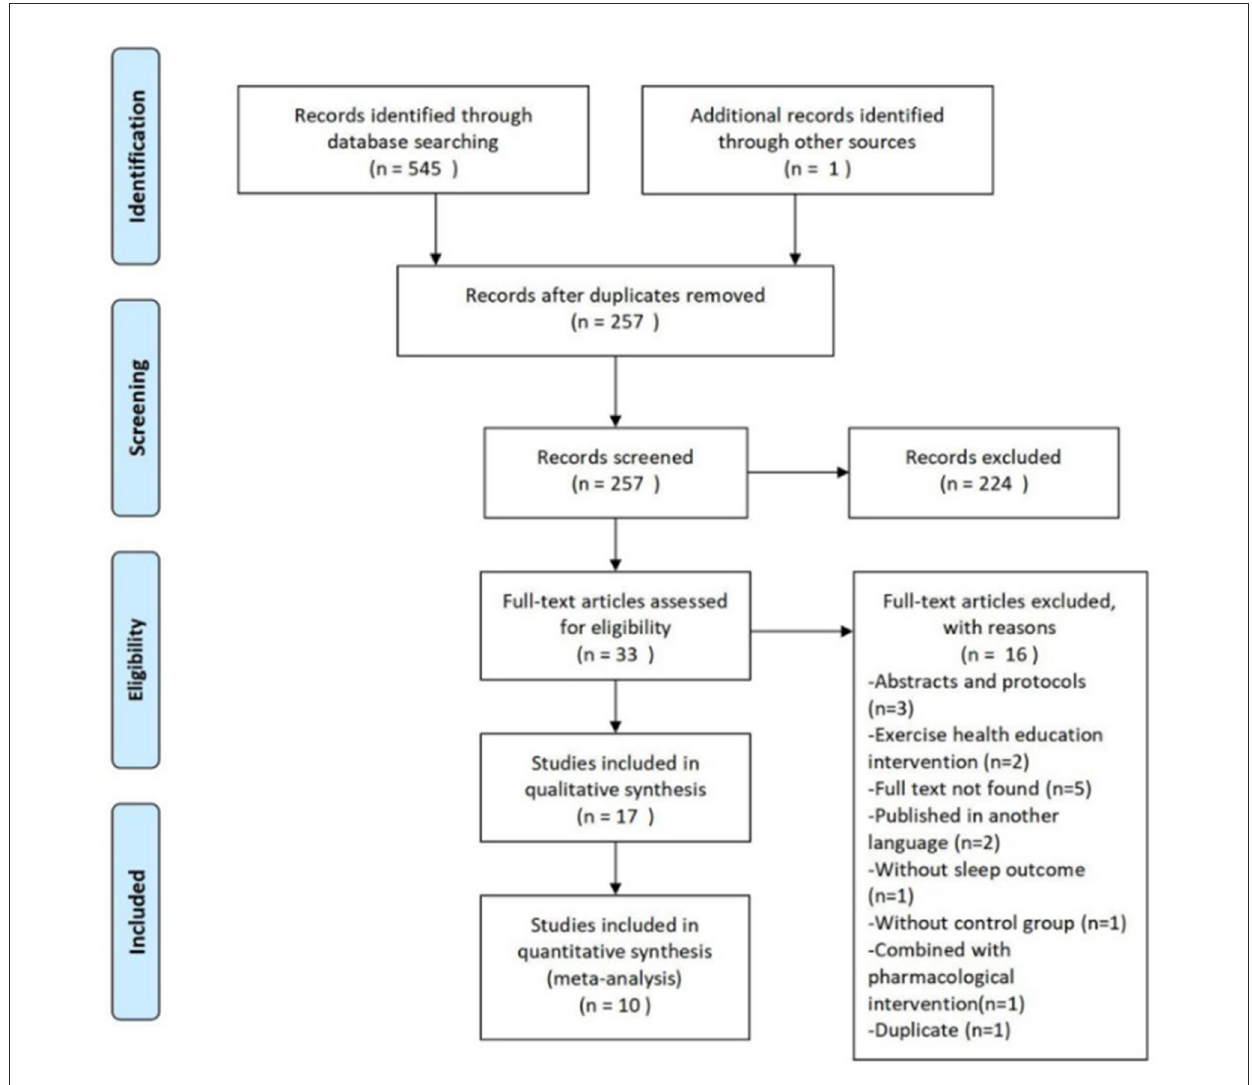
FIGURE1 PRISMA study inclusion